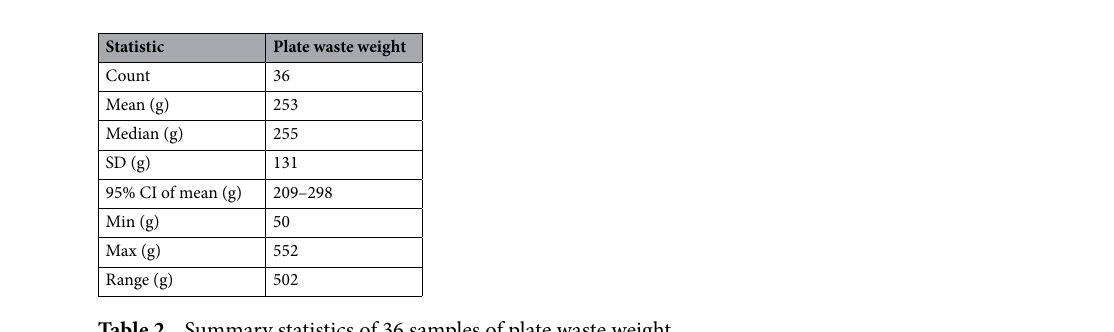
Table 2. Summary statistics of 36 samples of plate waste weight.